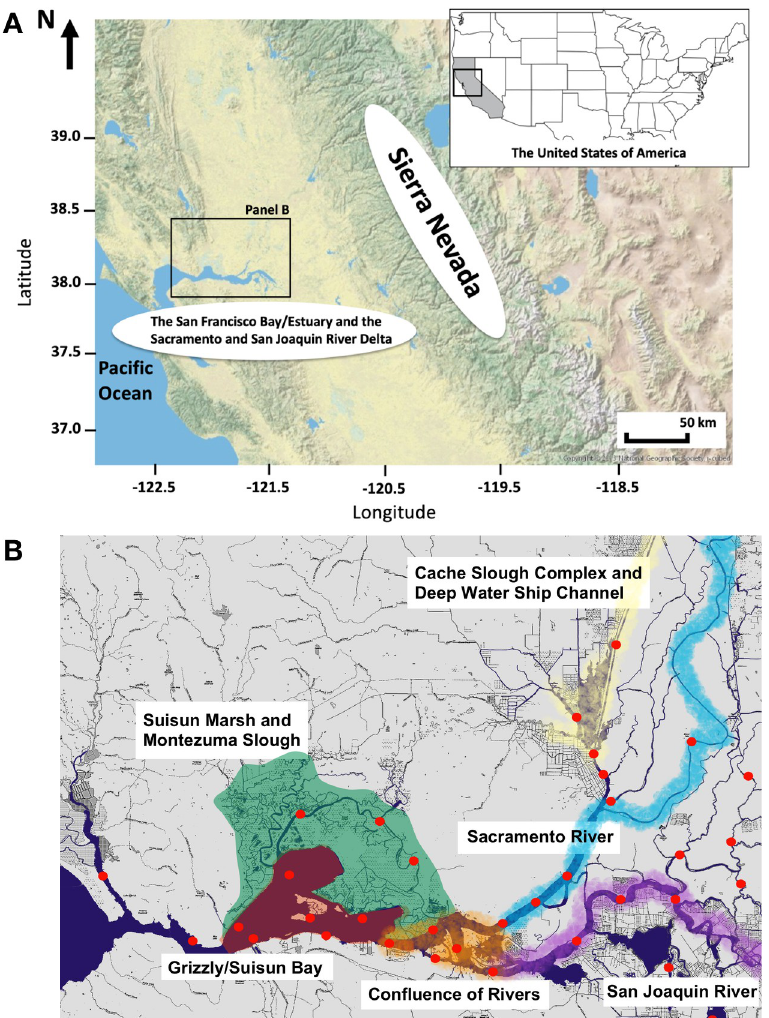
Fig 1. Map of Northern California, USA (Panel A) and the sampling stations (red points) for a long-term monitoring survey, Spring Kodiak Trawl Survey, conducted by the California Department of Fish and Wildlife (Panel B). The base maps were downloaded from the U.S. Geological Survey (https://apps.nationalmap.gov/viewer/). The sampling stations in the Panel B were plotted using the R package ‘ggmap’